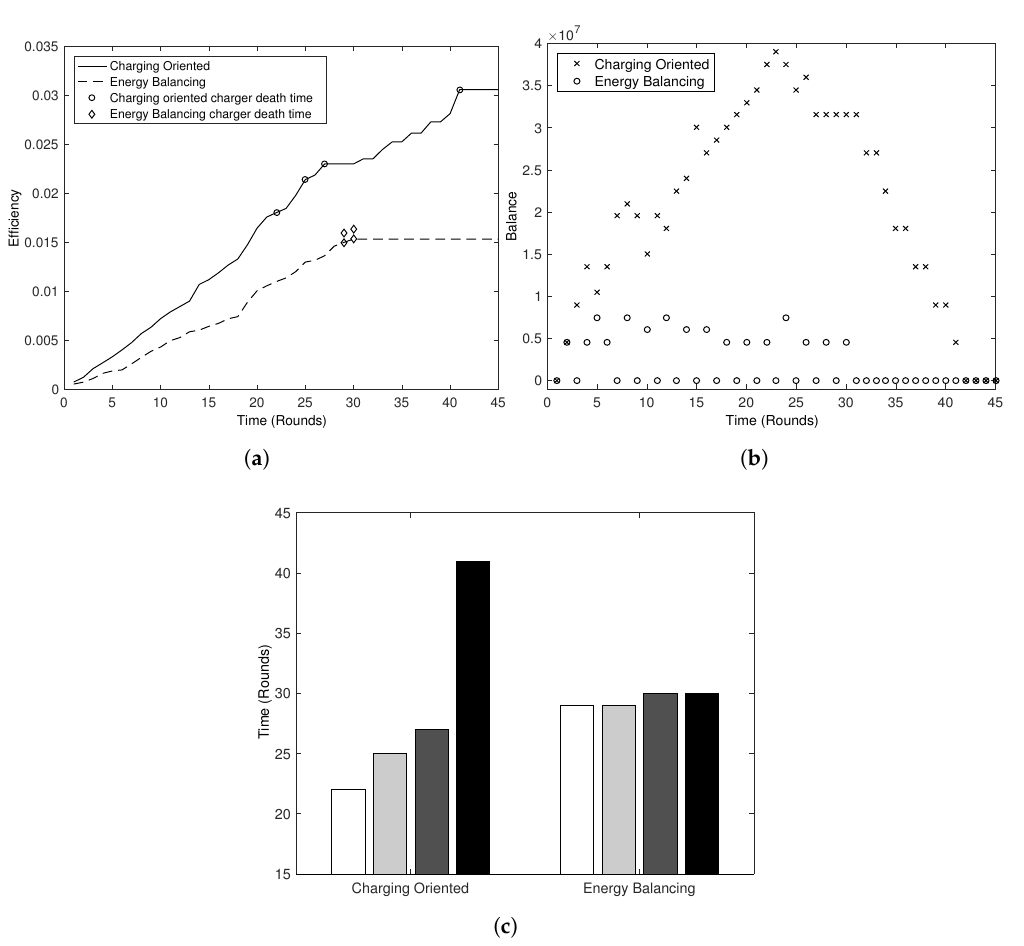
Figure 2. Experimental evaluation of the various metrics. ( a ) Cumulative charging efficiency over time. ( b ) Energy balance over time. ( c ) Lifetime of the